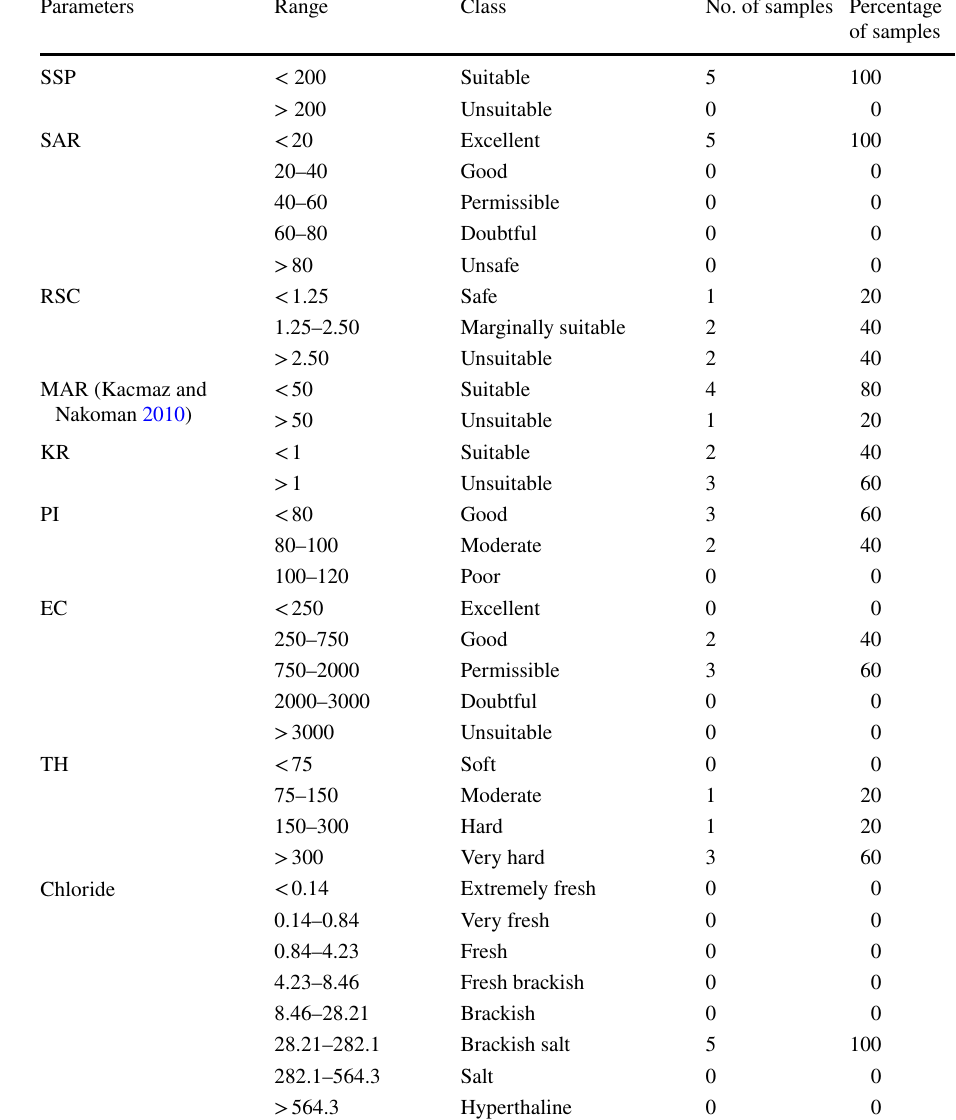
as per specified standards for different water quality